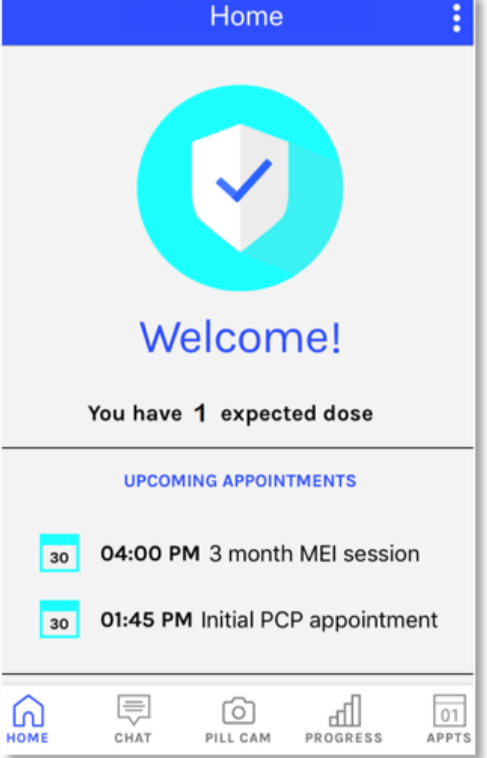
Figure 2. Wireframe of mobile app. MEI: mobile-enhanced intervention; PCP: Primary Care Provider.